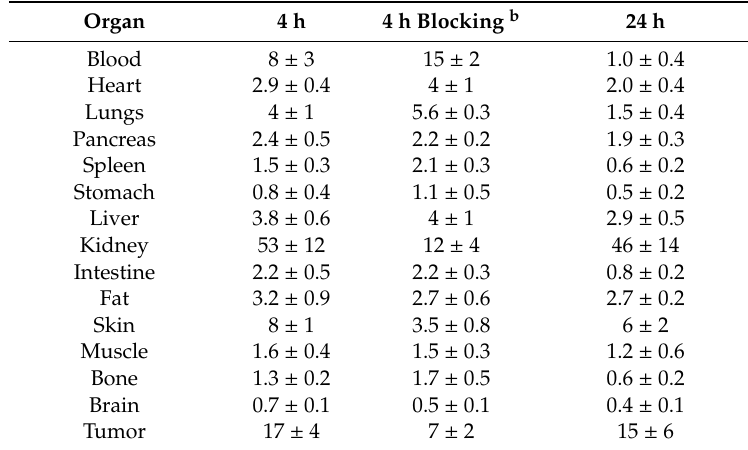
Table 4. Biodistribution of [ 55 Co]Co-rf42 in KB tumor bearing mice a .